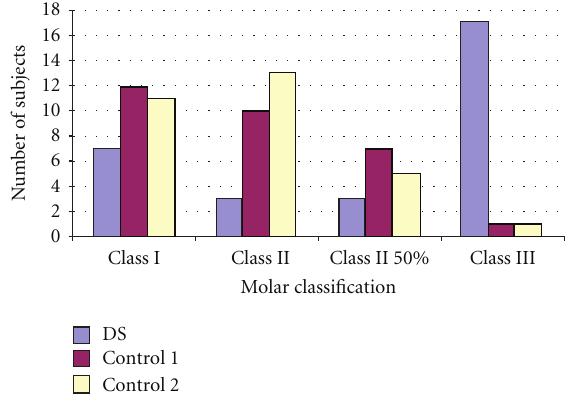
Figure 5: Distribution of molar classification. Table 6: Number and percentage of clinical dental characteristics. Clinical characteristics